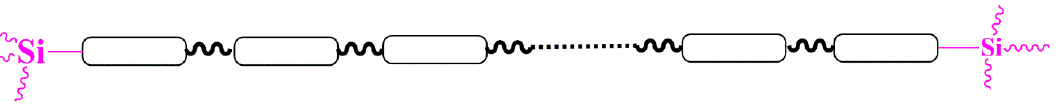
Figure 1. Modification of PU backbone with siloxane.